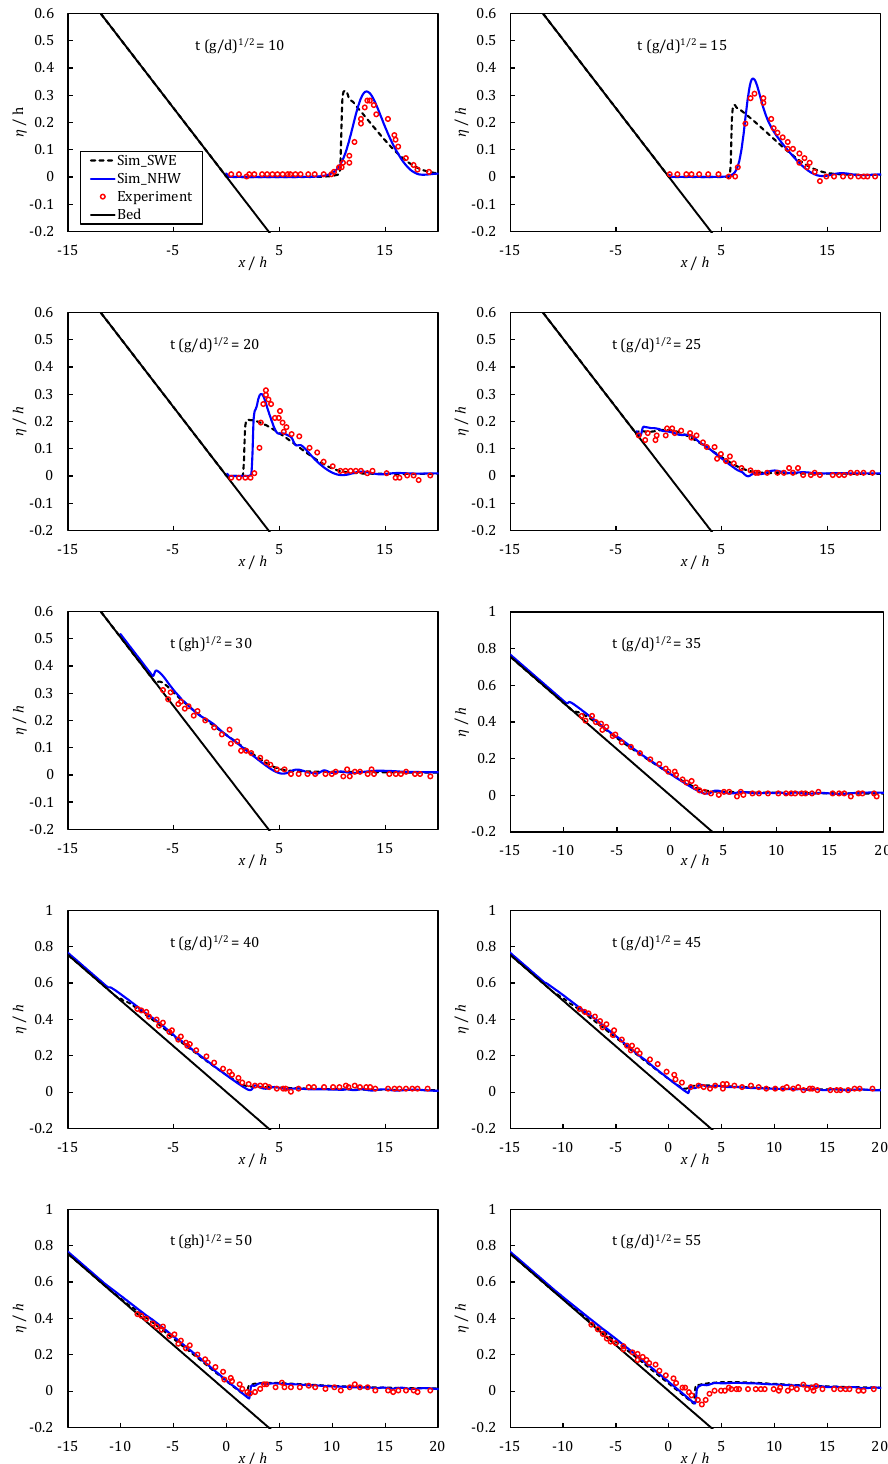
Figure 6. Comparisons of results from shallow water equation (SWE), non-hydrostatic wave model (NHW) models and measurements at different times for breaking solitary wave runup and